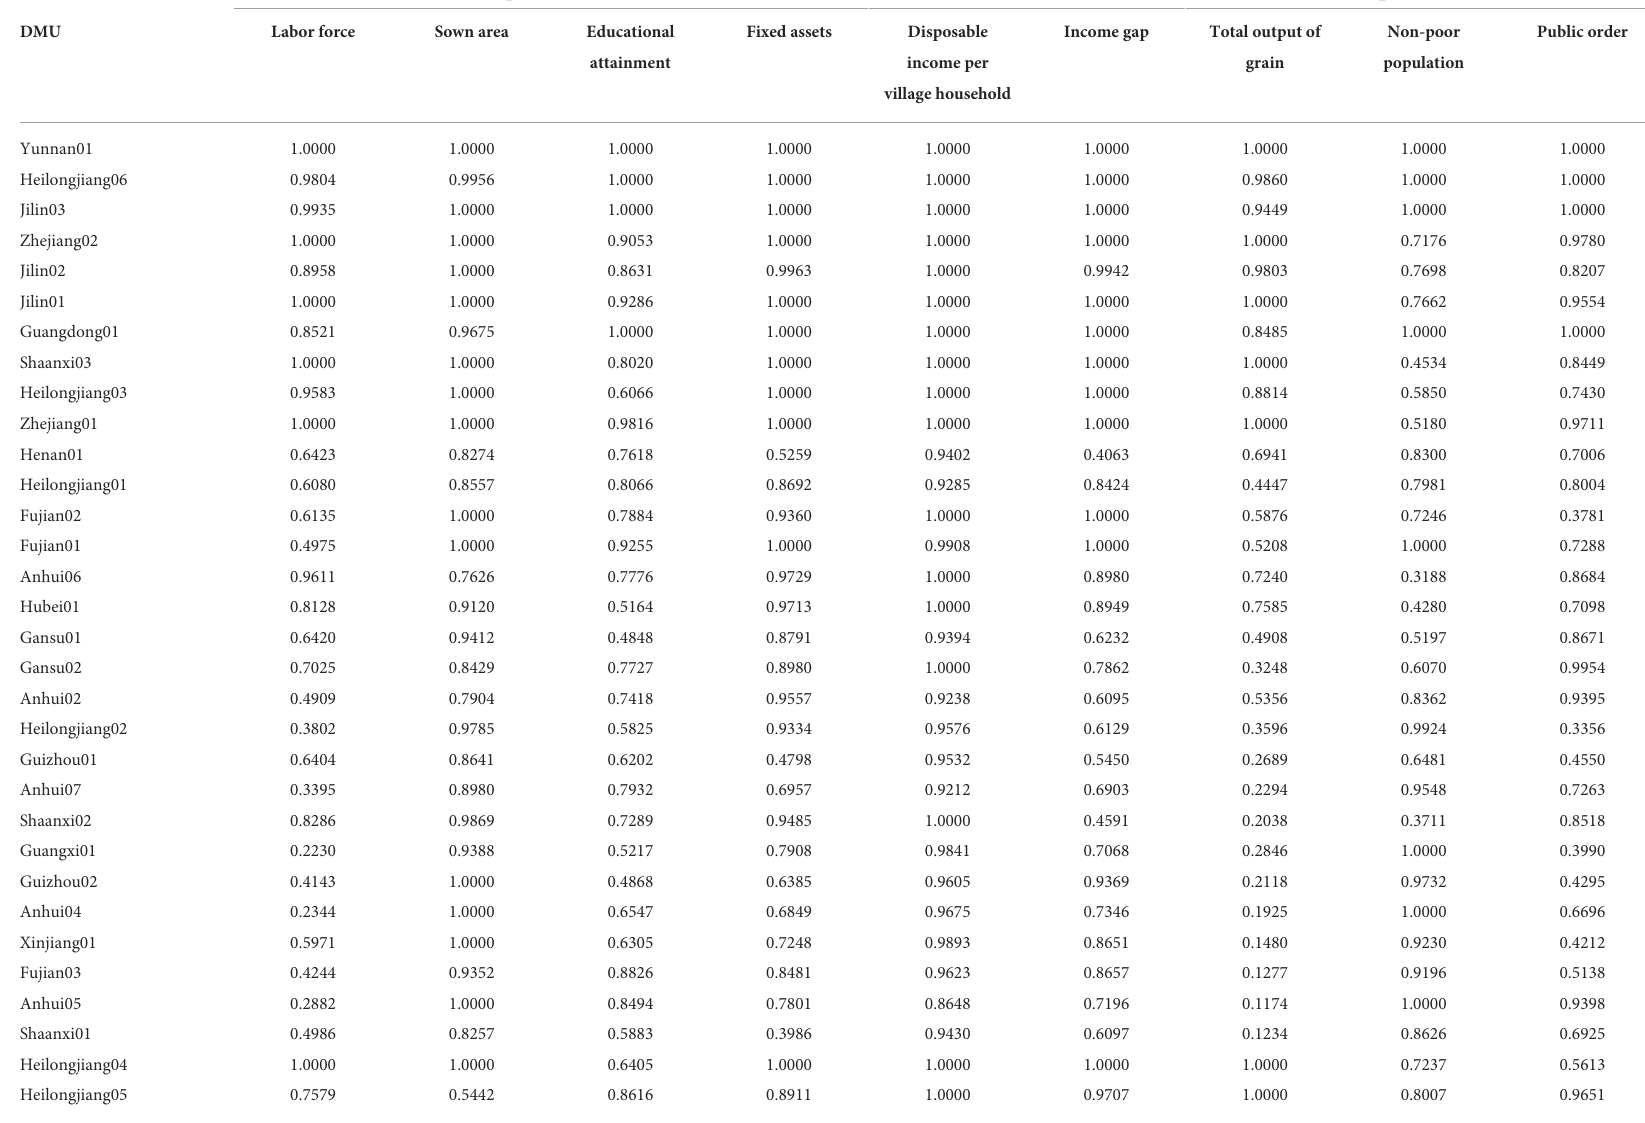
TABLE 3 Average efficiency of input and output indicators in 5 years (2012 to